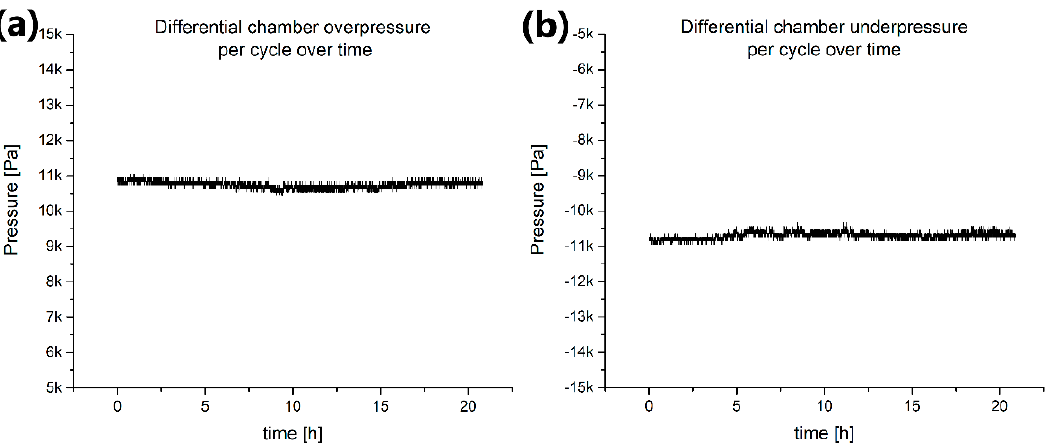
Figure 10 . ( a ) Differential pressures reached by each cycle inside the chamber over time, with the pump mounted in overpressure configuration. ( b ) The same experiment, with the pump mounted in vacuum configuration.